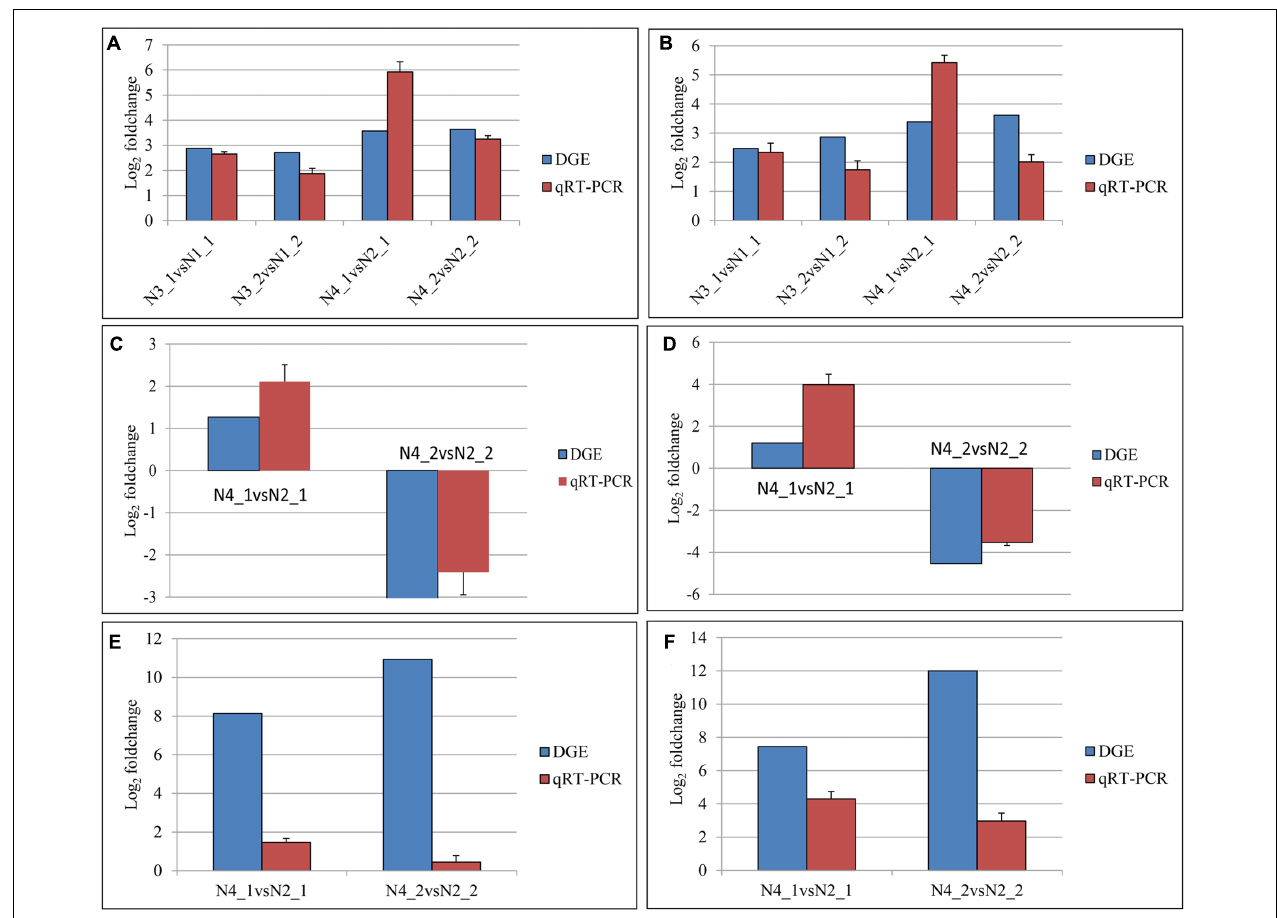
FIGURE 11 | Quantitative real-time PCR (qPCR) validations of gene expression levels from digital gene expression (DGE) analysis. The qPCR values are presented as the averages of three independent experiments. The genes were randomly selected. “N3_1 vs N1_1” indicates a comparison between the gene expression in the N3_1 library with that in the N1_1 library, and the same describes the other labels. The y -axis indicates the log 2 (foldchange) obtained by two methods. The (A–F) indicates the genes with the assay names of BnaA10g11500D , BnaC02g11480D , BanA01g13280D , BanC08g44890D , BanA08g21880D , and BnaC01g38680D ,